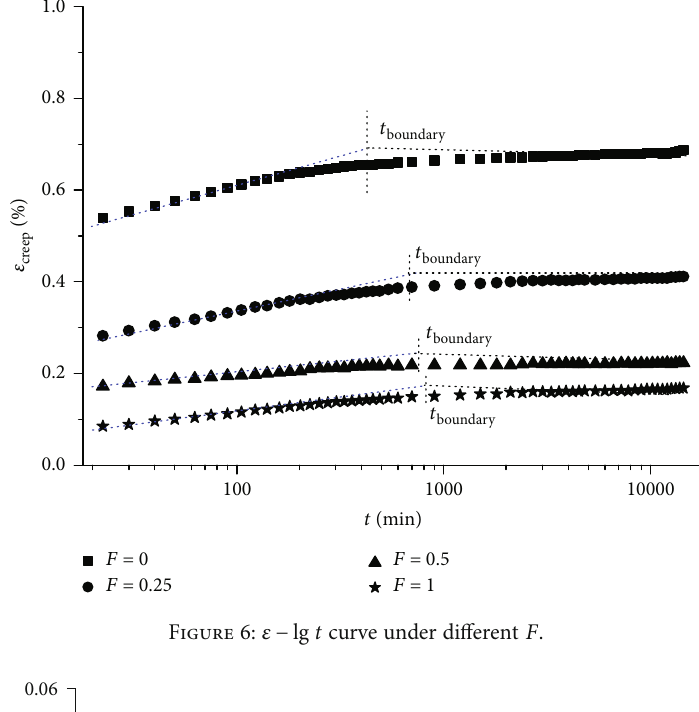
Figure 6: ε − lg t curve under di ff erent F .